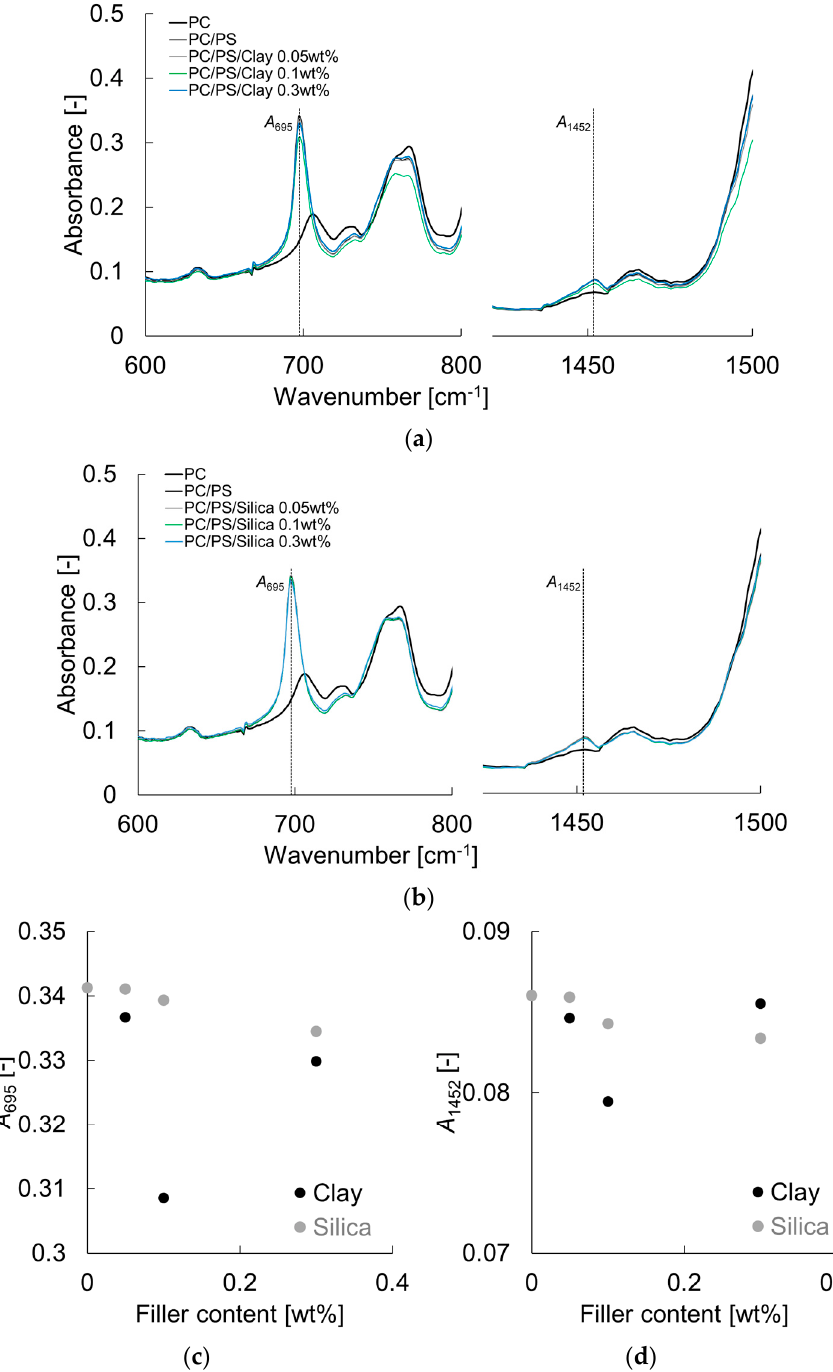
Figure 3. FT-IR spectra of PC/PS/clay and PC/PS/silica: ( a ) PC/PS/clay; ( b ) PC/PS/silica; ( c ) A 695 ;